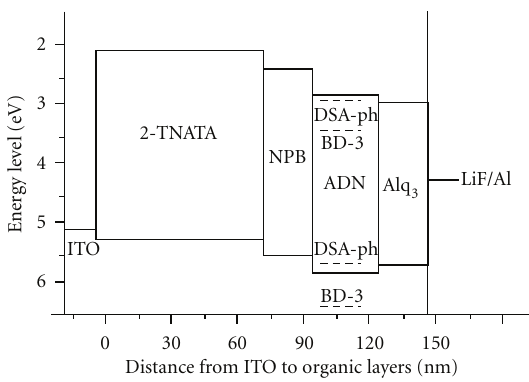
Figure 1: Device structure and energy levels of Device B.